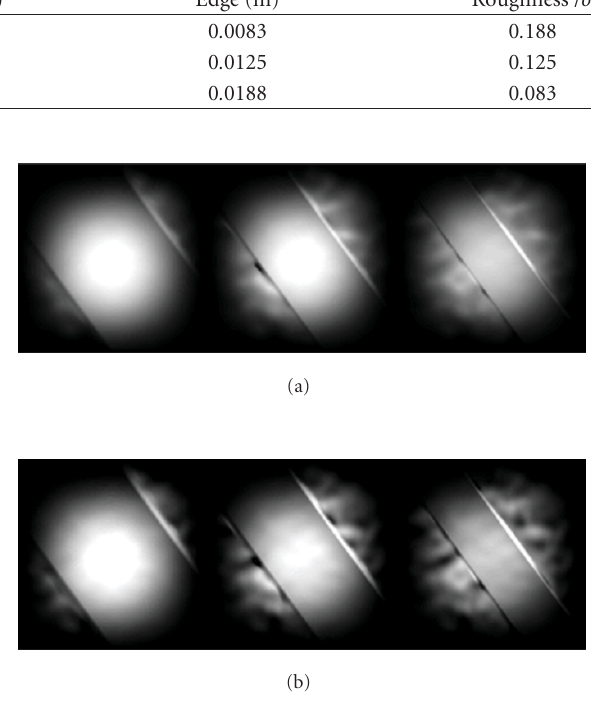
Figure 4: Graphic representation of (a) HH and (b) VV surface reflectivities modulated by the SAR point-spread function used to calculate SAR pixel values for a single pixel in a single realisation of the surface with the modelled tyre-track impression: wide track (on the left), medium track (centre), and thin track (on the